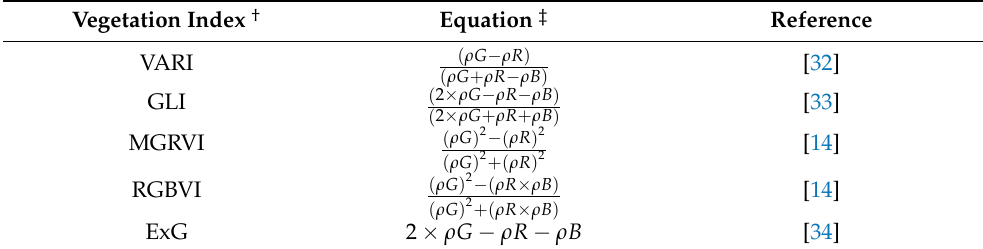
Table 3. Vegetation indices used in this study and their accompanying equations. Vegetation Index